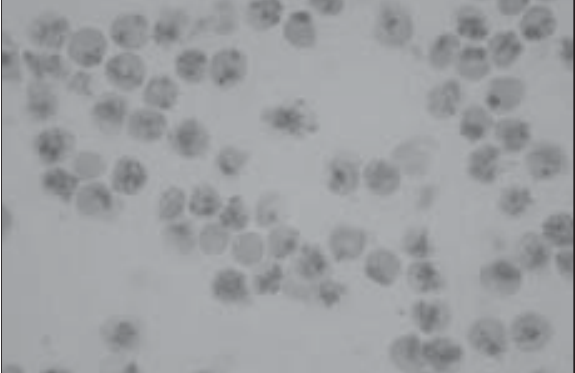
Figure 2 – Erythrocytes with precipitates of Heinz bodies. Source: LMSL